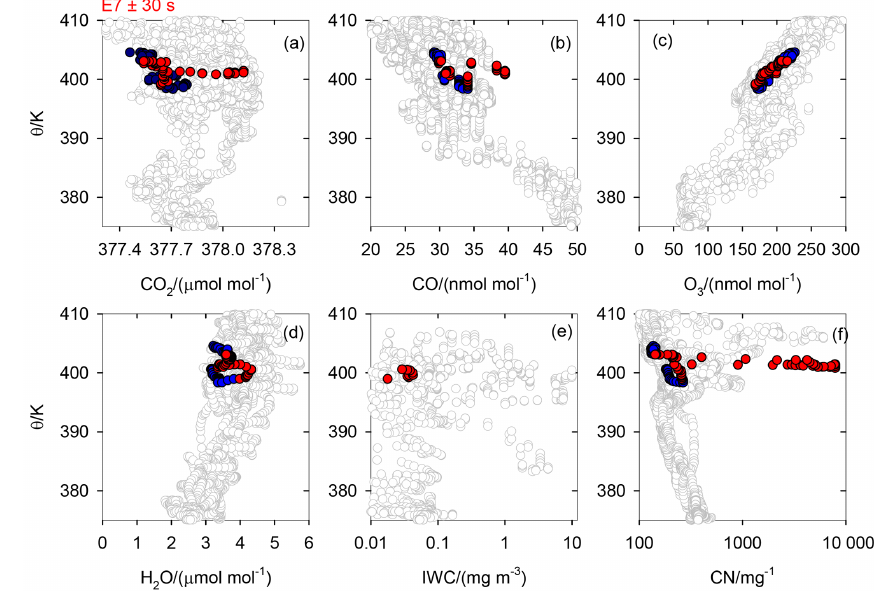
Figure 10. Case E7: best example for a contrail-induced ice event. Same data as in Fig. 8 but at 1Hz resolution. Gray: all data; red: data within ± 30s before and after t = 21633; and blue: neighbors in the next 30s intervals before and after this